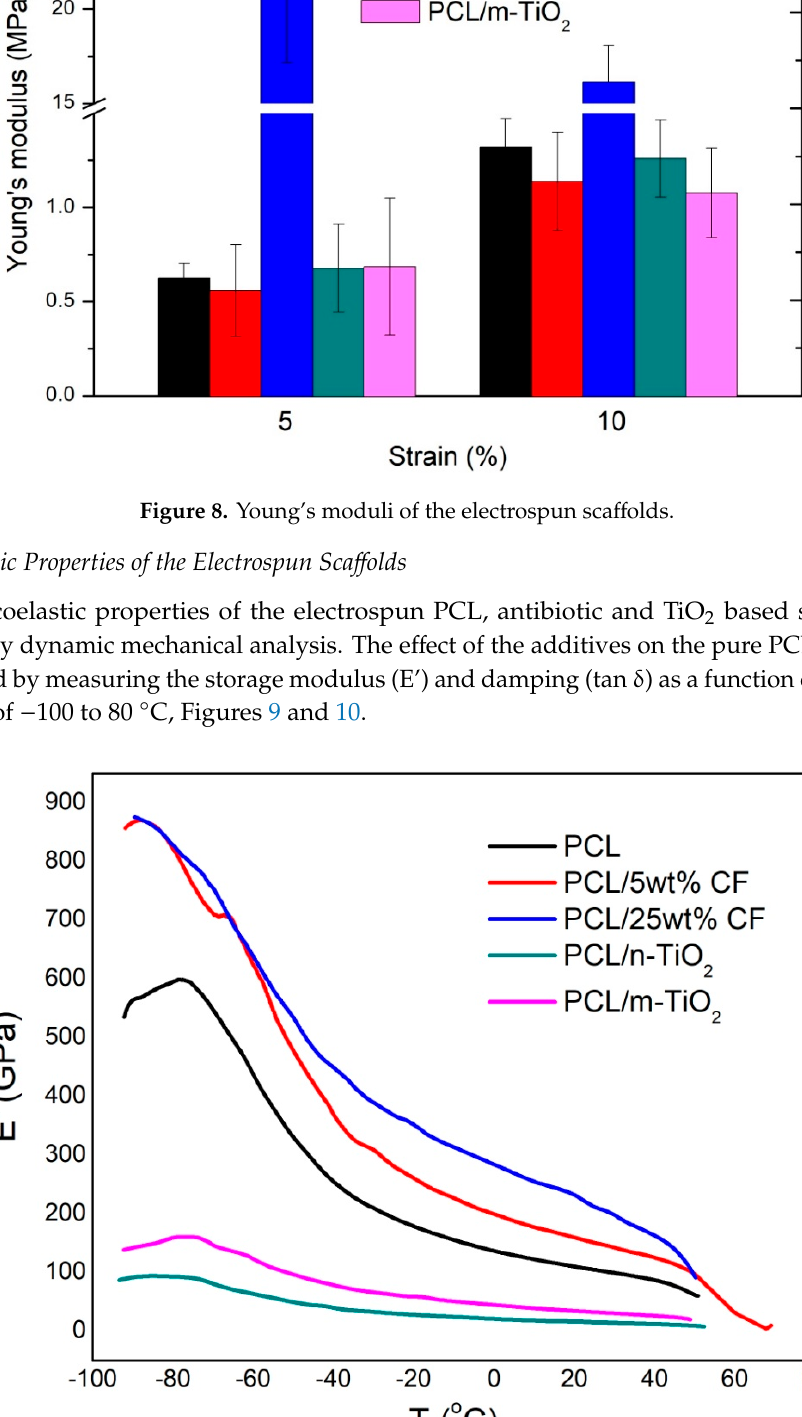
3. Figure 10 改为以下图片 Figure 9. Storage modulus as a function of temperature of the electrospun sca Figure 9. Storage modulus as a function of temperature of the electrospun scaffolds.